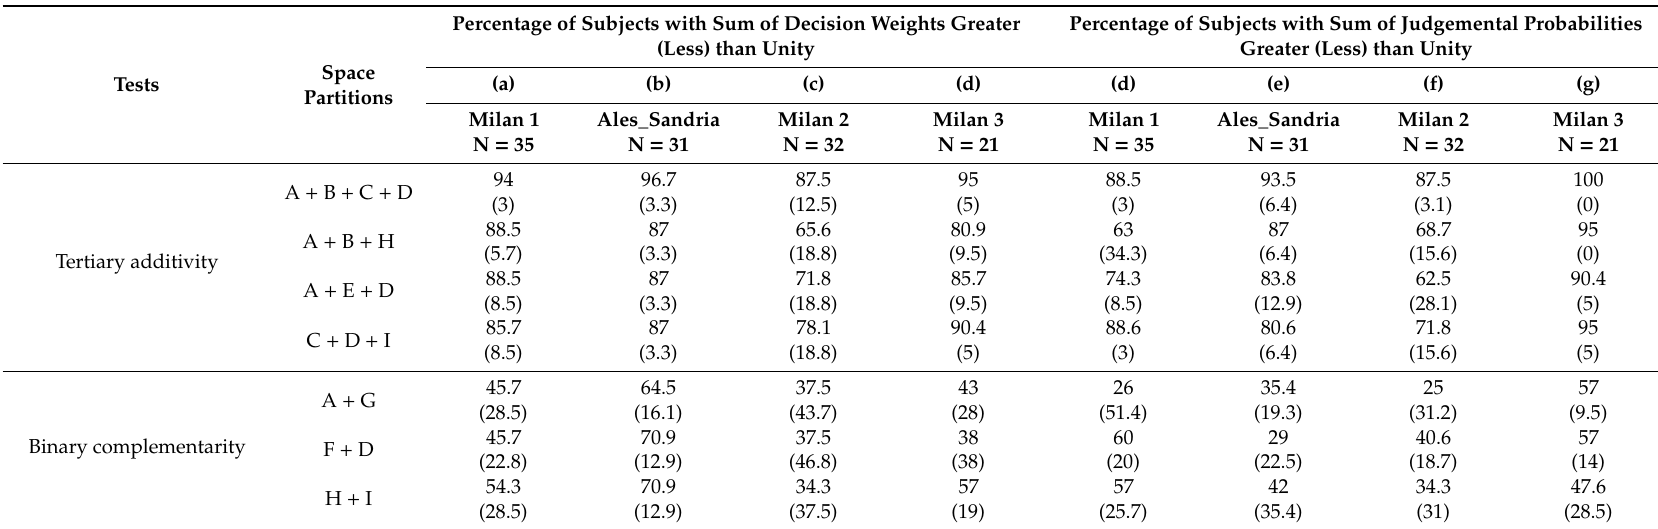
Table A3. Percentage of subjects violating